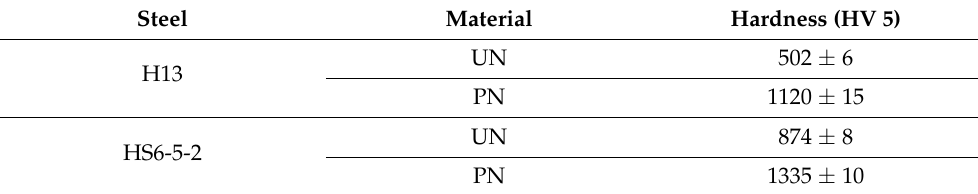
Table 4. Surface hardness of the UN materials and PN materials.